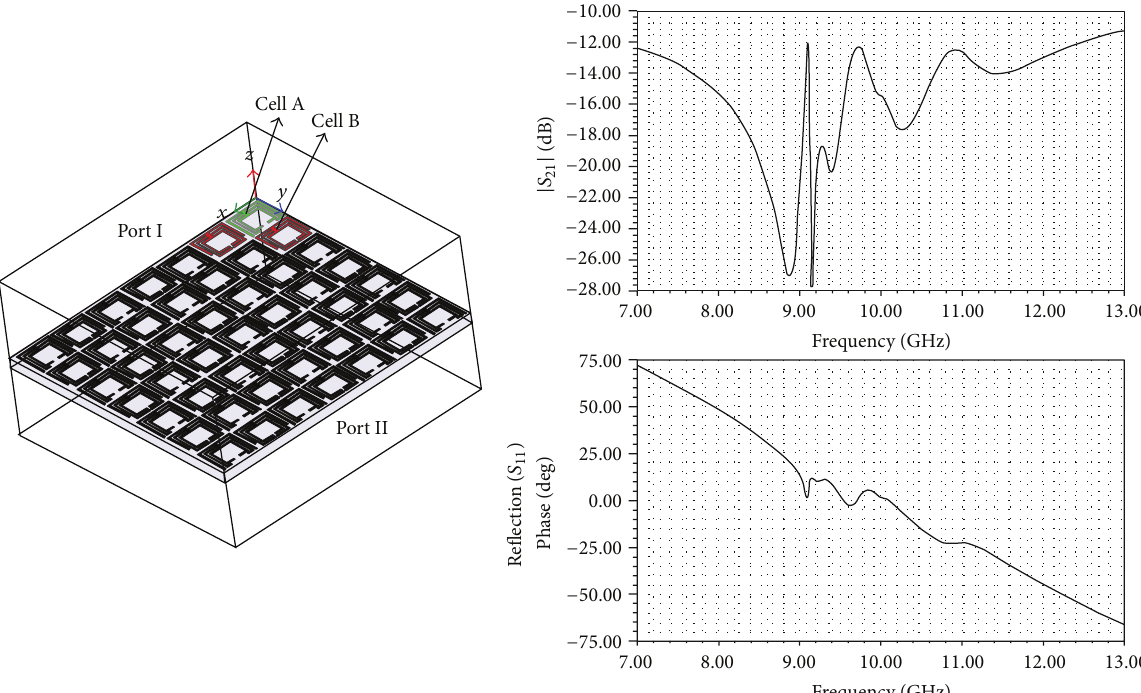
Figure 5: Reflected-wave unit-cell box study setup of the FSS screen and the related results, S 21 and the phase (S 11 ).